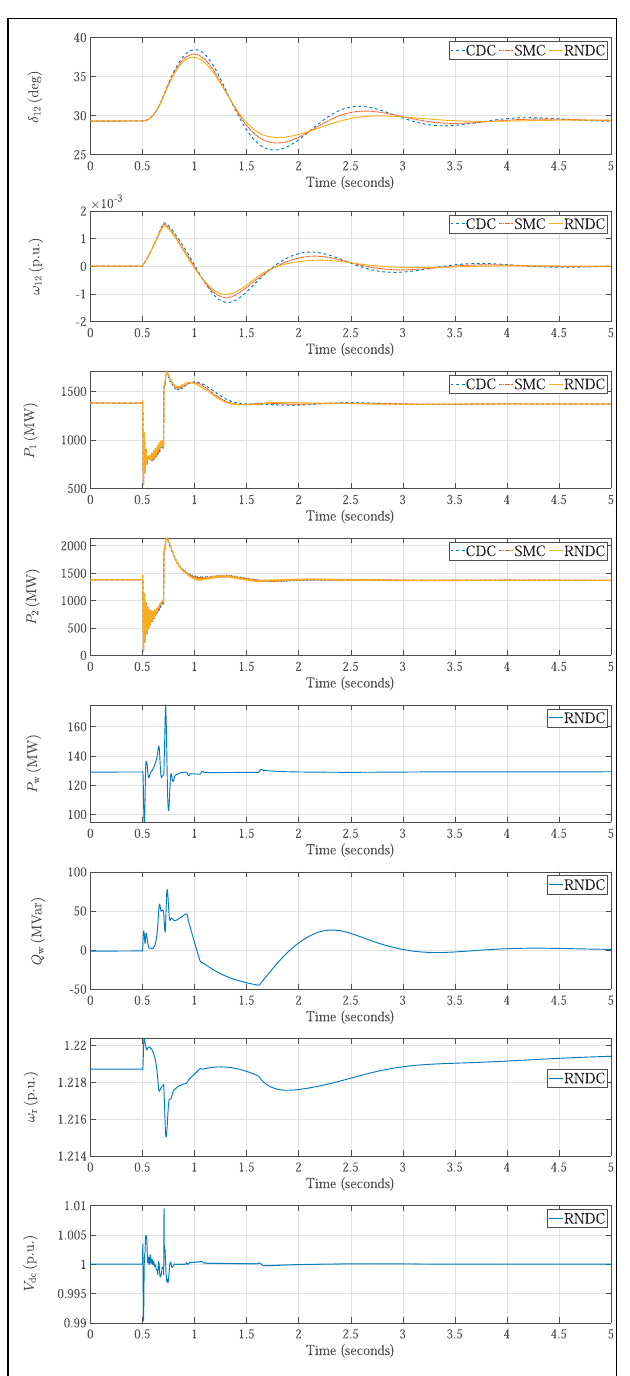
FIGURE 4 | Simulation results obtained in the case where a three-phase-to-ground fault occurs in the middle of the transmission line.